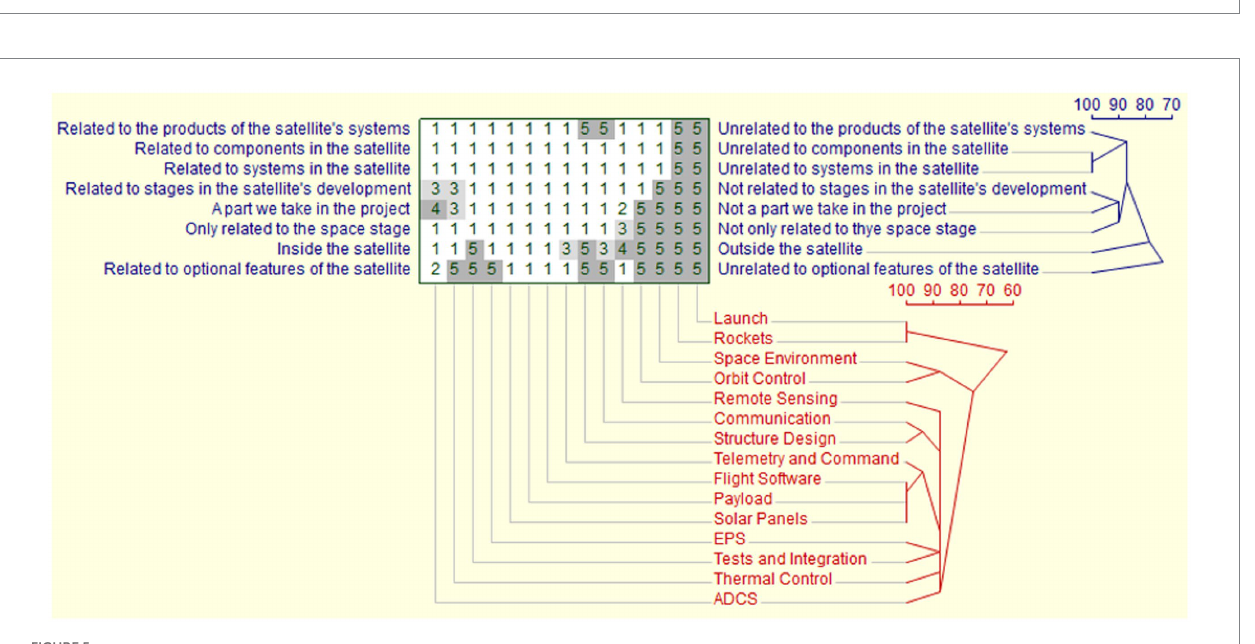
FIGURE 5 John’s second repertory